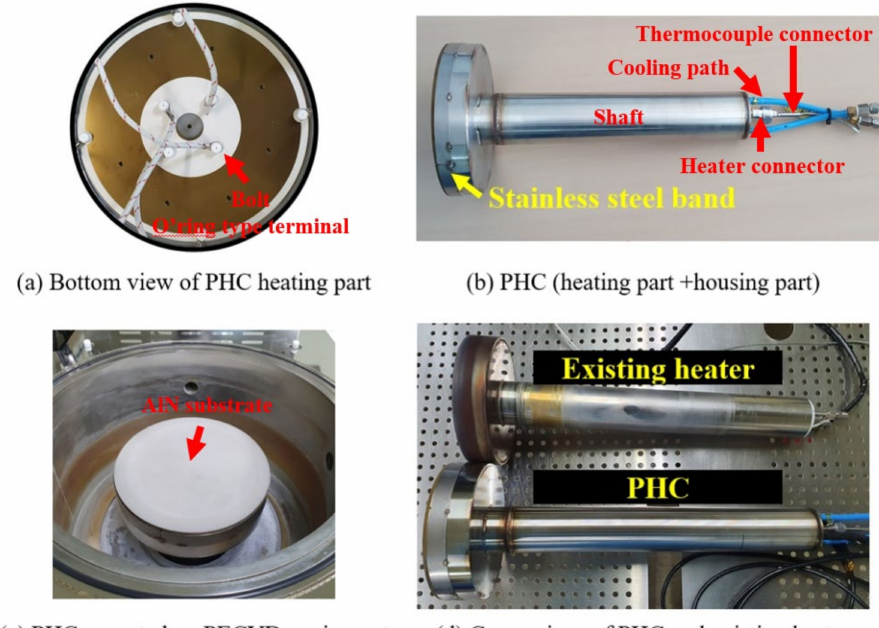
Figure 7b. The substrate and housing of the PHC were fixed with a stainless steel band during the performance test due to a design error. The PHC substrate was aluminum nitride, which has various advantages as a substrate material [24], including high thermal conductivity, which improves the temperature uniformity, as shown in Figure 7c. To carry out PECVD process test of PHC, PHC was fabricated in the same shape as the existing heater of our PECVD equipment, as shown in Figure 7d. The thermocouple connected to a power supply was contacted with the center of the PHC substrate, as shown in Figure 2. The power supply controls the temperature using the proportional integral derivative (PID) method.